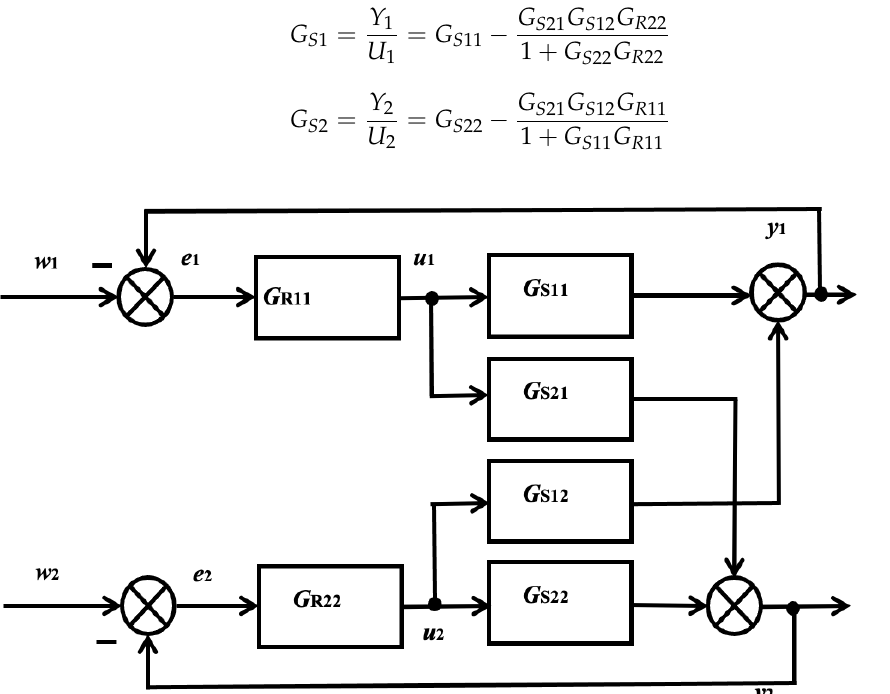
Figure 1. Decentralized system control with two inputs and two outputs, the so-called P structure.